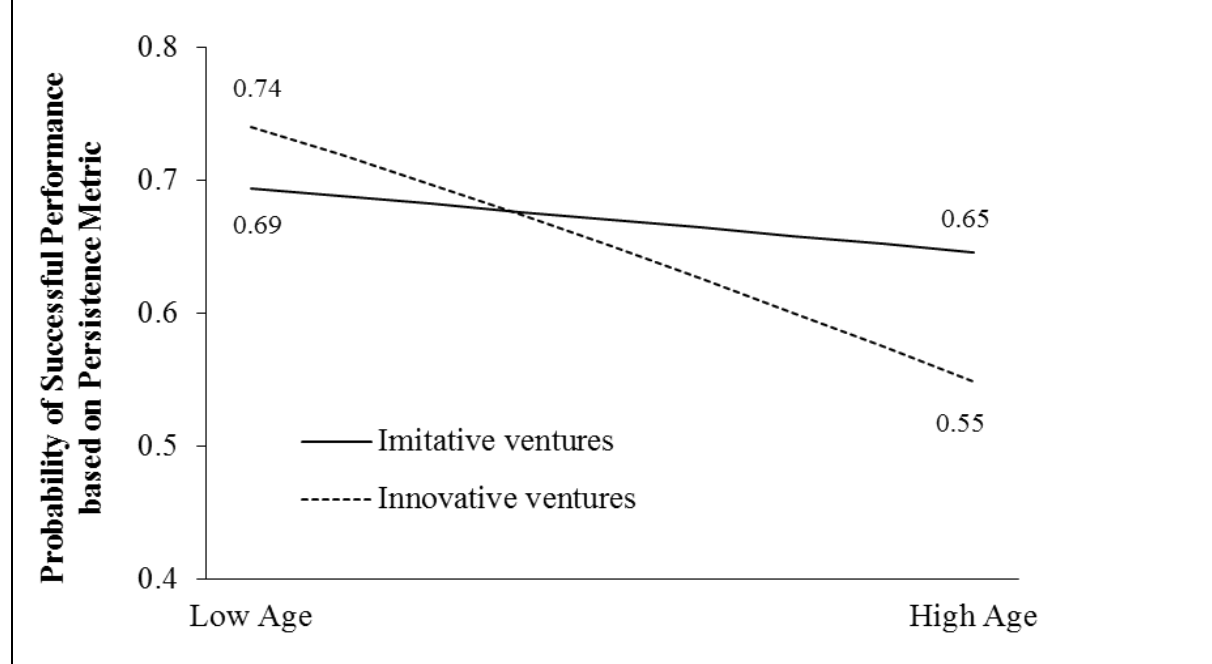
Figure 1. Moderating effect of venture innovativeness on the relationship between entrepreneur age and